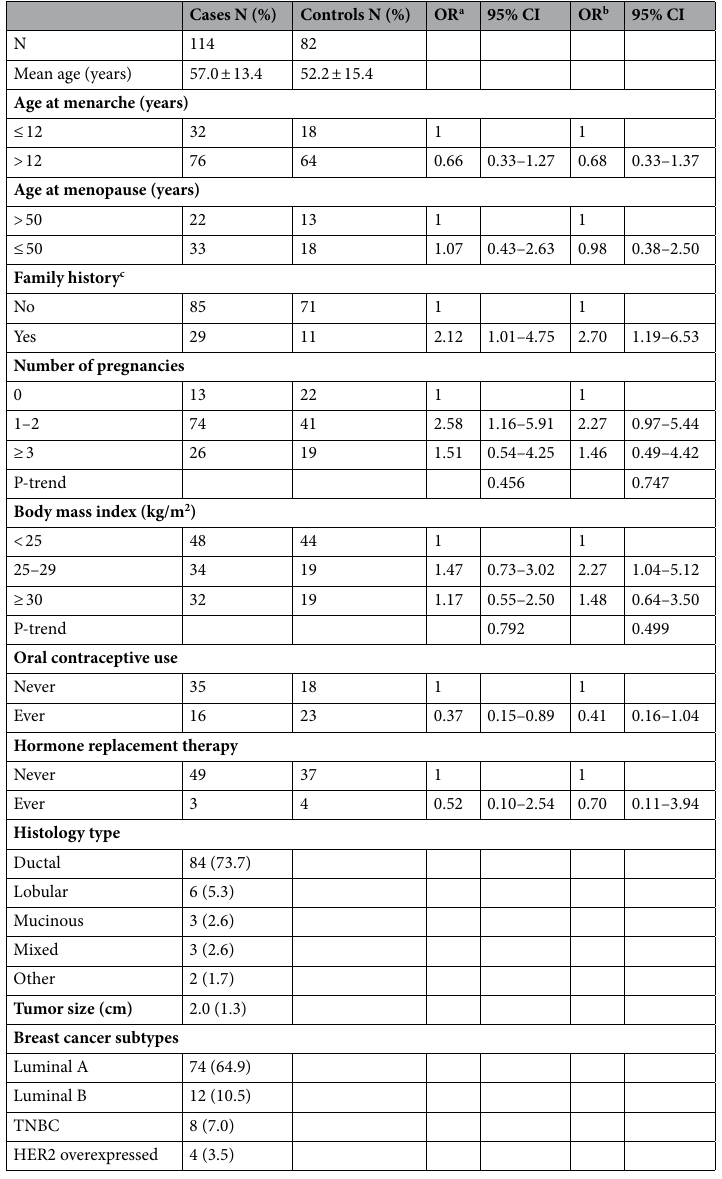
Table 1. Associations between risk/protective factors for breast cancer and breast cancer risk. a Adjusted for age at diagnosis (cases) and age at interview (controls). b Further adjusted for age at menarche, parity, menopausal status, BMI, and family history. c Defined as one or more first and/or second-degree relatives with breast and/or ovarian